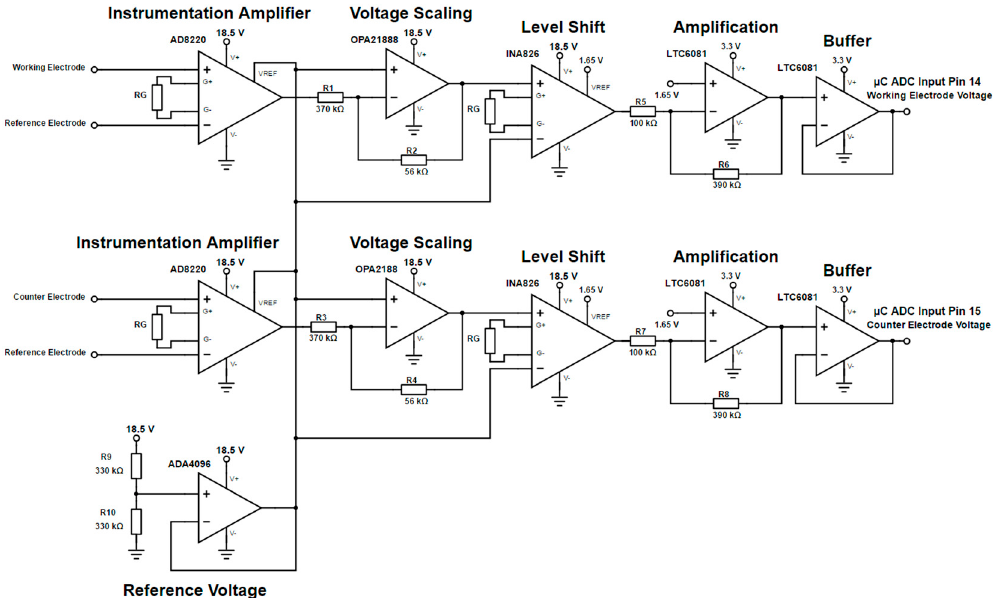
Figure 16. Circuit schematic for measuring the WE-RE and CE-RE transient voltages.